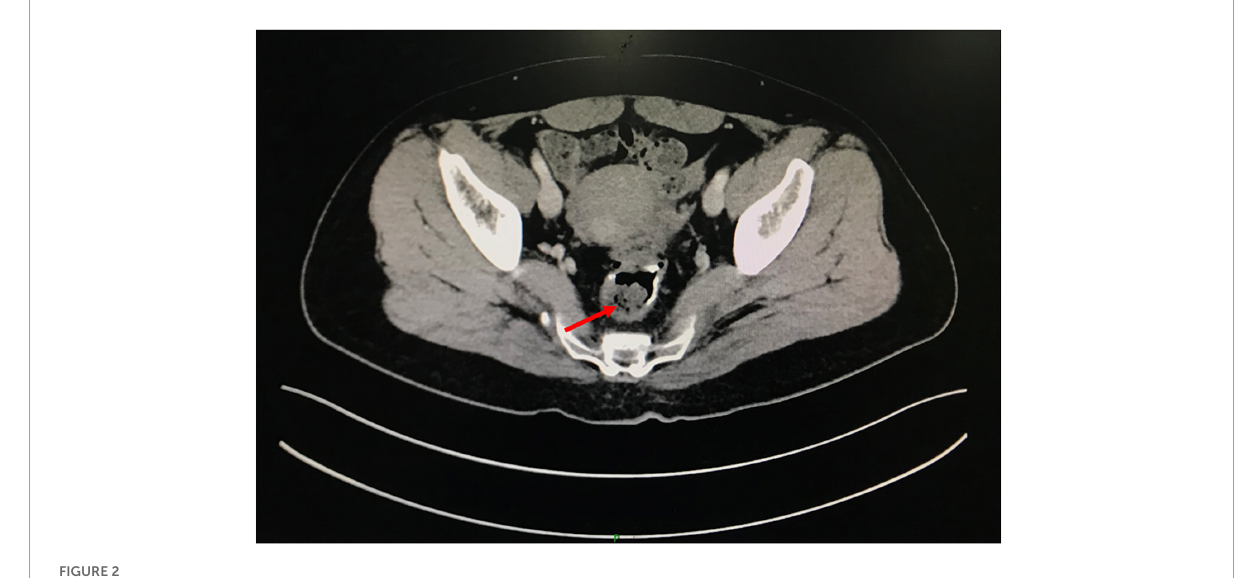
FIGURE2 The pelvic cavity CT image.